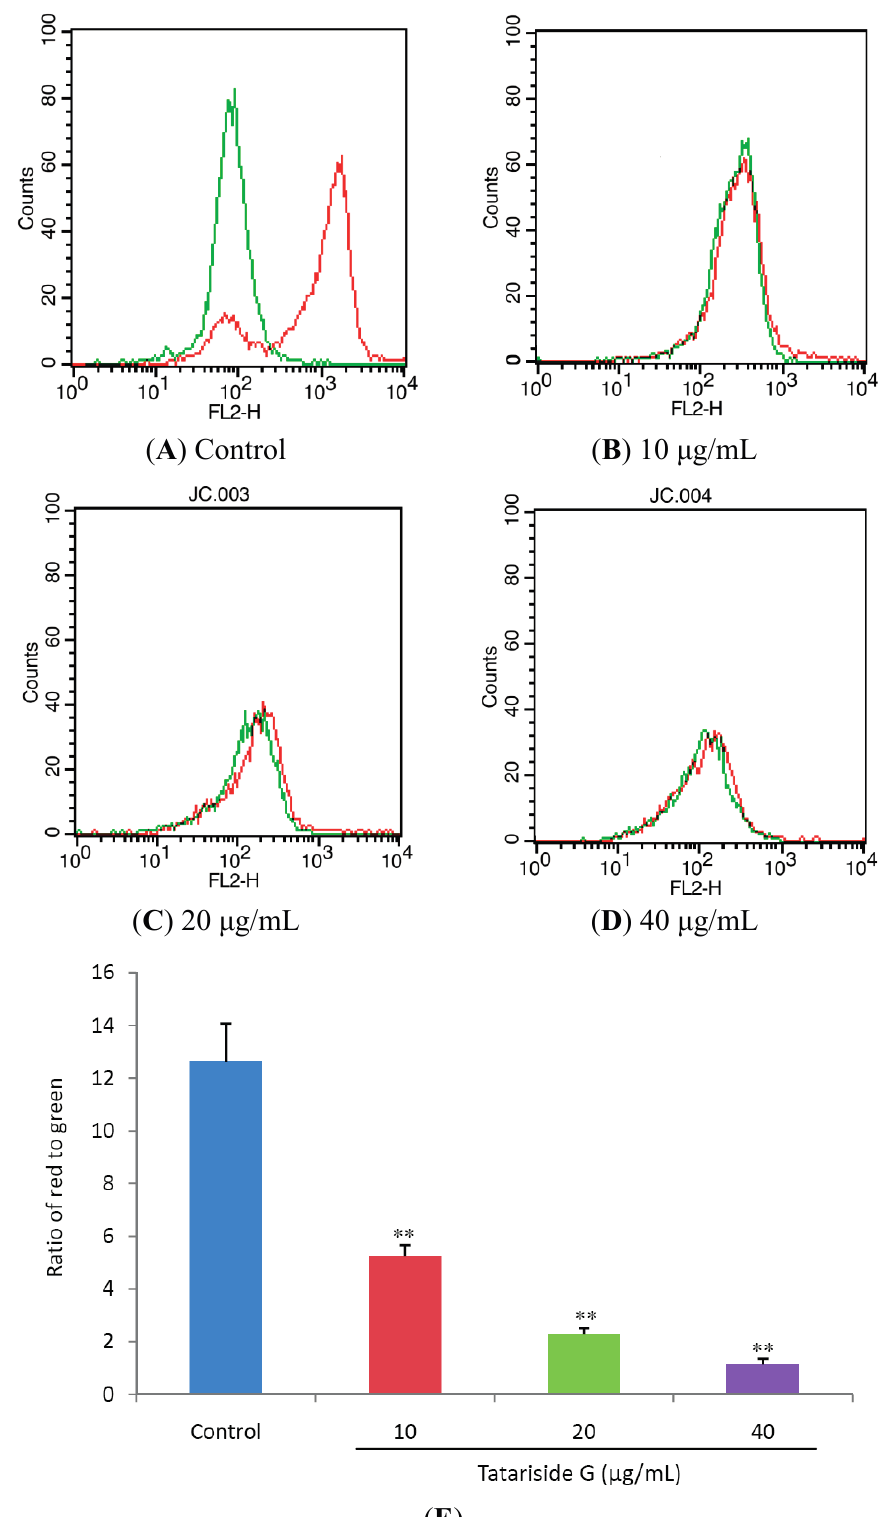
Figure 5. Effects of tatariside G on mitochondrial membrane potential (MMP). ( A )–( D ) Following treatment with tatariside G for 12 h, the fluorescent intensity of JC-1 in HeLa cells was determined respectively in FL1 and FL2. ( E ) MMP was estimated by the ratio of red to green fluorescene intensity. ** p < 0.01 vs. the control group. Data are expressed as the mean ± SD. n =